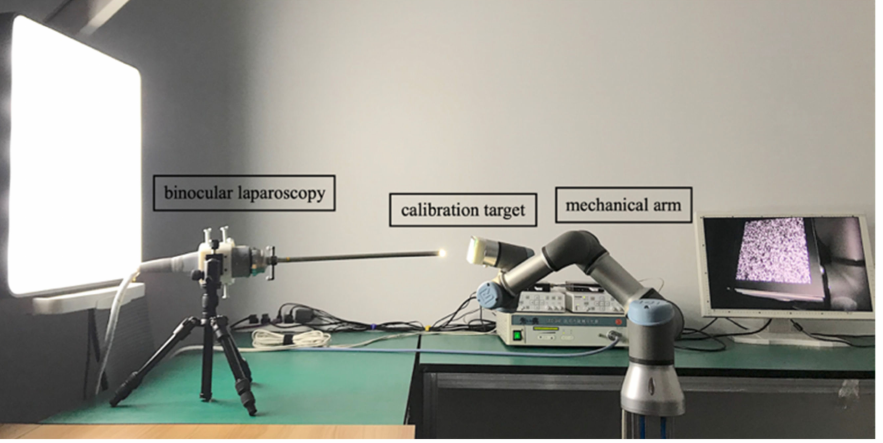
Figure 8. Experimental setup.